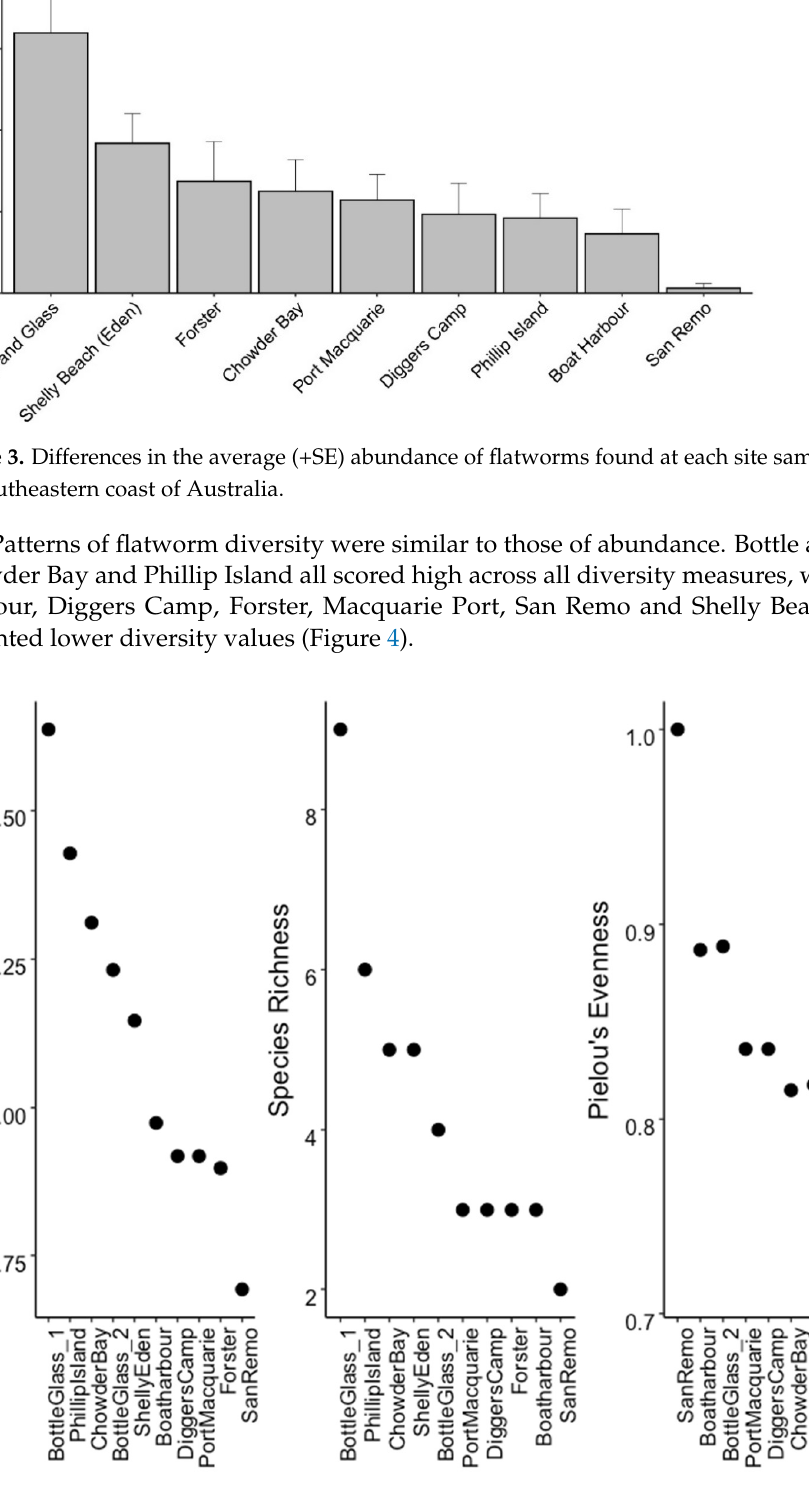
Figure 4. Different diversity indices for flatworms at each site. Bottle and Glass was sampled on two occasions and as such each sampling event has been separated in the figure.